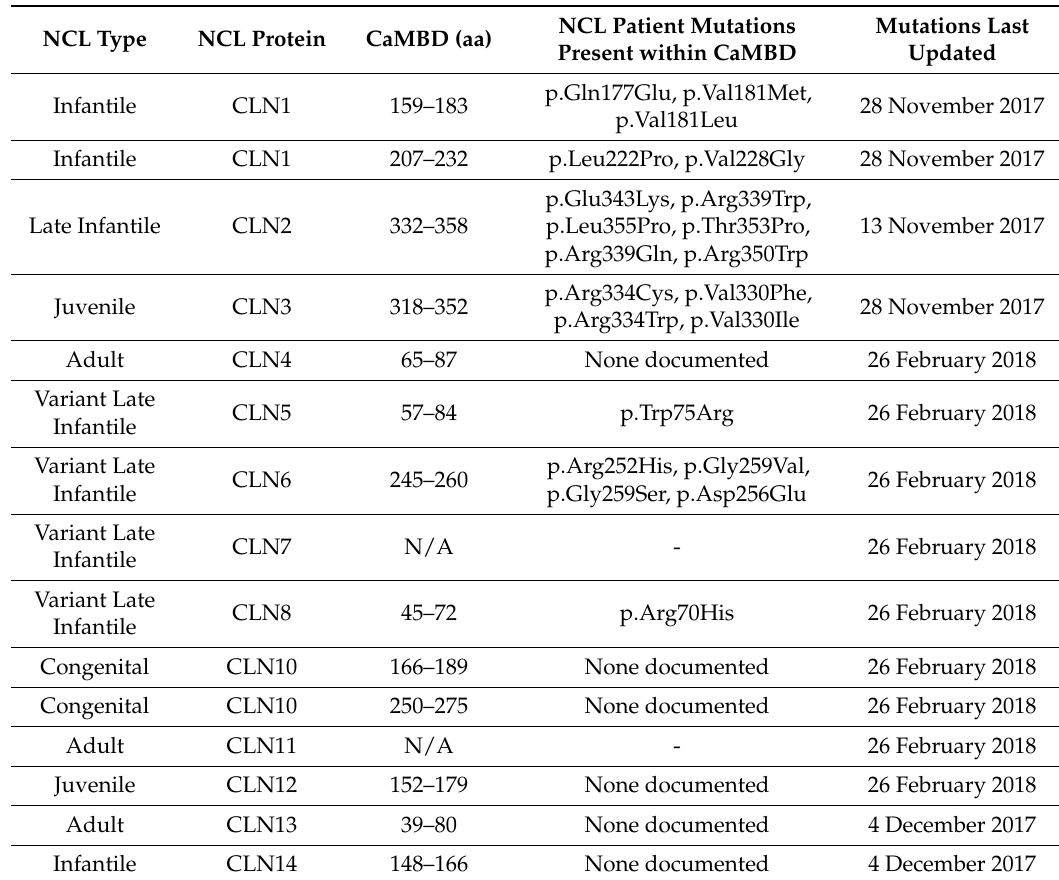
Table 3. List of patient mutations present within the putative calmodulin-binding domains (CaMBDs) of proteins linked to neuronal ceroid lipofuscinosis